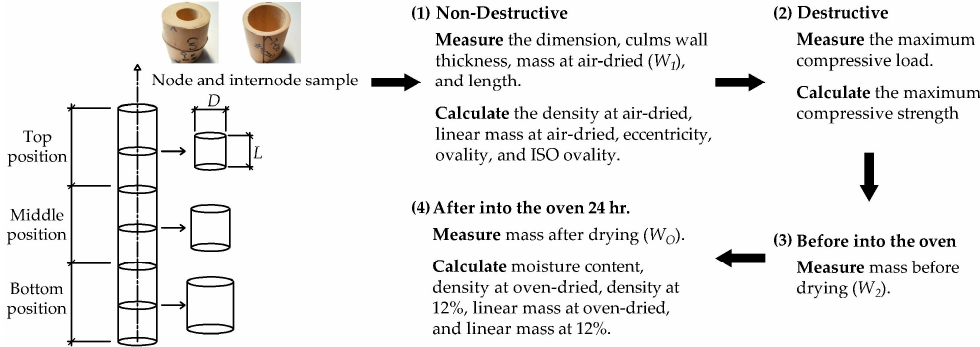
Figure 3. Sampling process and experiments.